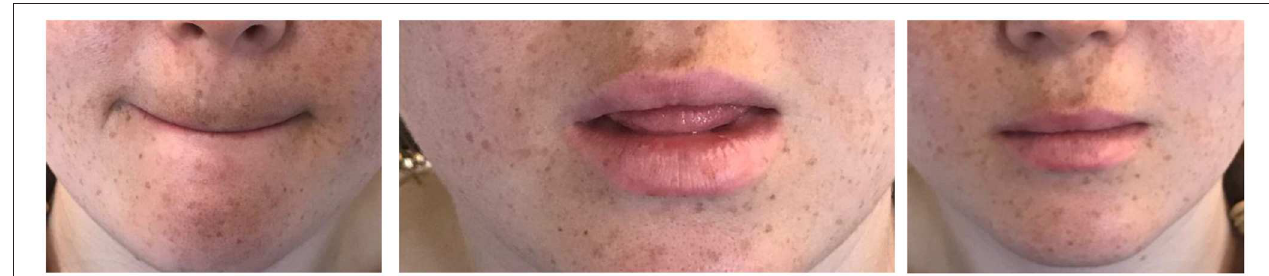
FIGURE 2 | An illustration of the lip stimulation, tongue stimulation and the control condition.